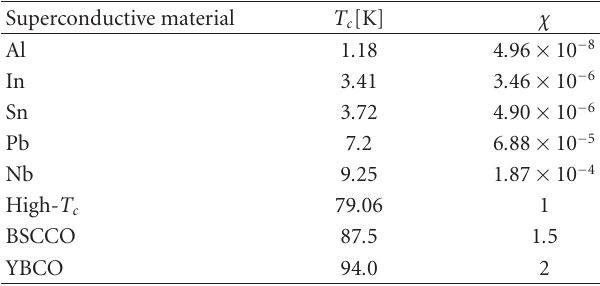
Table 1: Predicted coupling χ between the gravitomagnetic field and the angular velocity for di ff erent superconductive